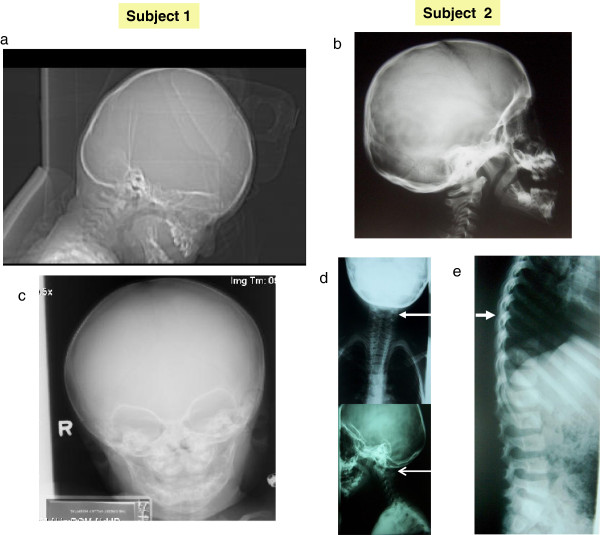
Skull and skeletal abnormalities in two subjects. a, b) brachycephaly in Subject 1 (a) and 2 (b); c) occipital asymmetry in Subject 1; d) congenital C1-C2 vertebral block; e) accentuation of dorsal kiphosis (arrow) in subject 2.